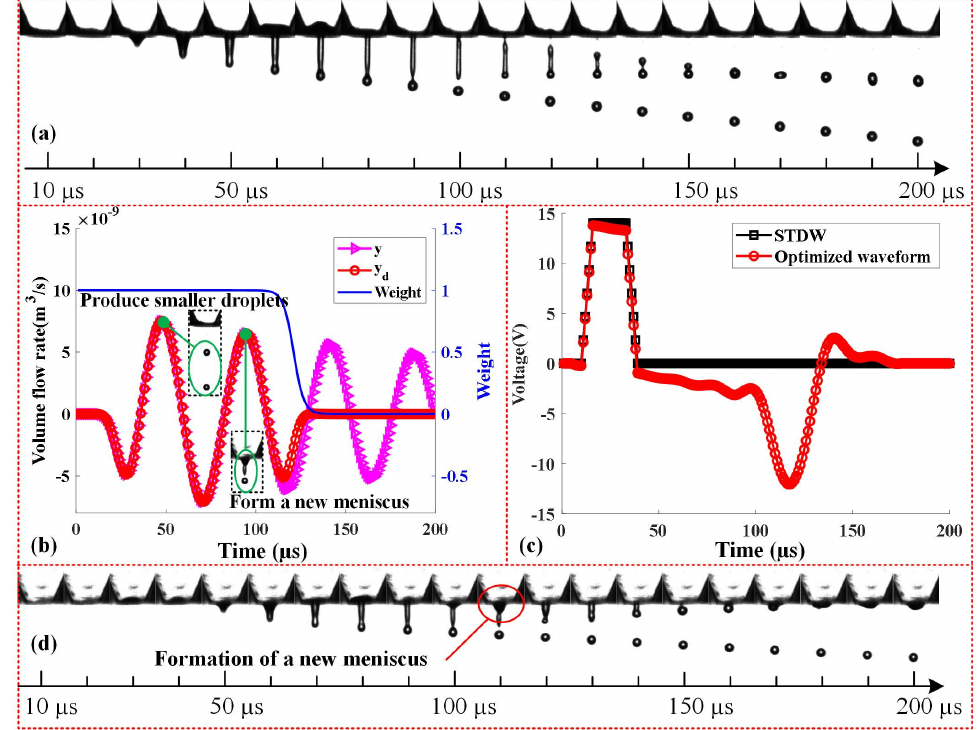
Figure 8. ( a ). Process of forming two smaller droplets (ethanol is used as the fluid). ( b ). Desired volume flow rate to produce smaller droplet. ( c ). Optimized waveform obtained using iterative learning. ( d ). Process of generating a smaller droplet using the optimized waveform.